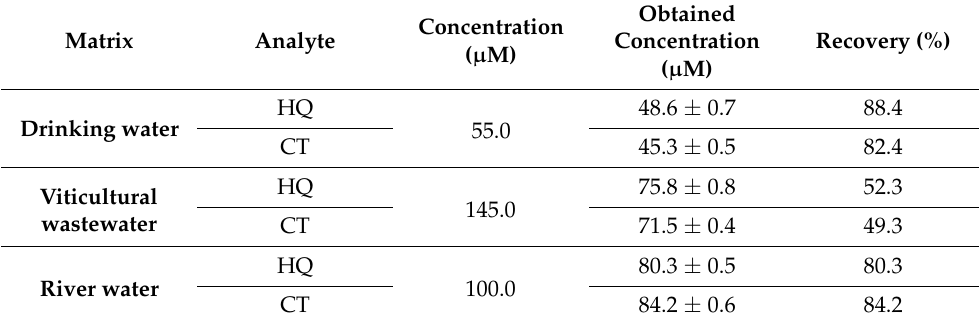
Table 2. Standard addition determination of hydroquinone ( n = 10) in different aqueous matrices by differential pulse voltammetry, recovery coefficients and experimental t ( α = 0.05) for each determination